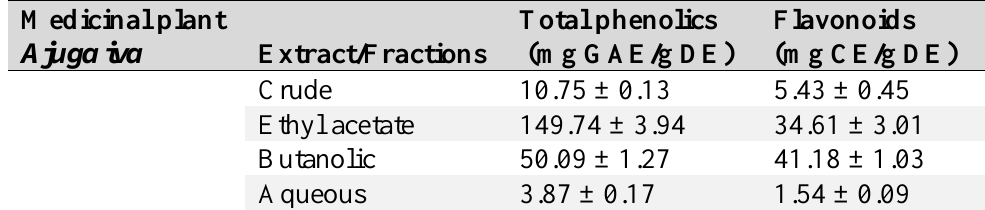
Table 1. The total phenolic and flavonoid contents of